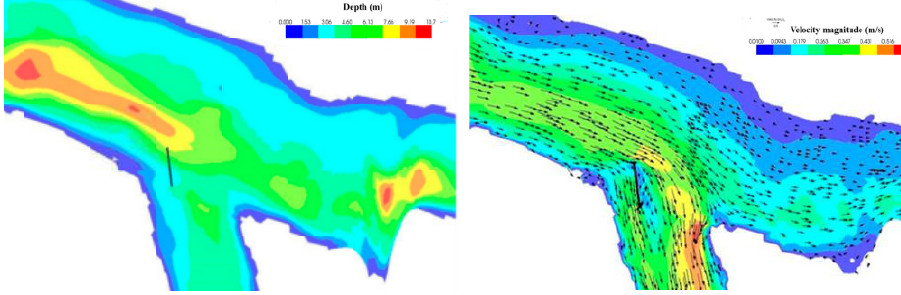
Figure 7. Simulated flow depth and velocity distribution with its vectors (modified after [90]).